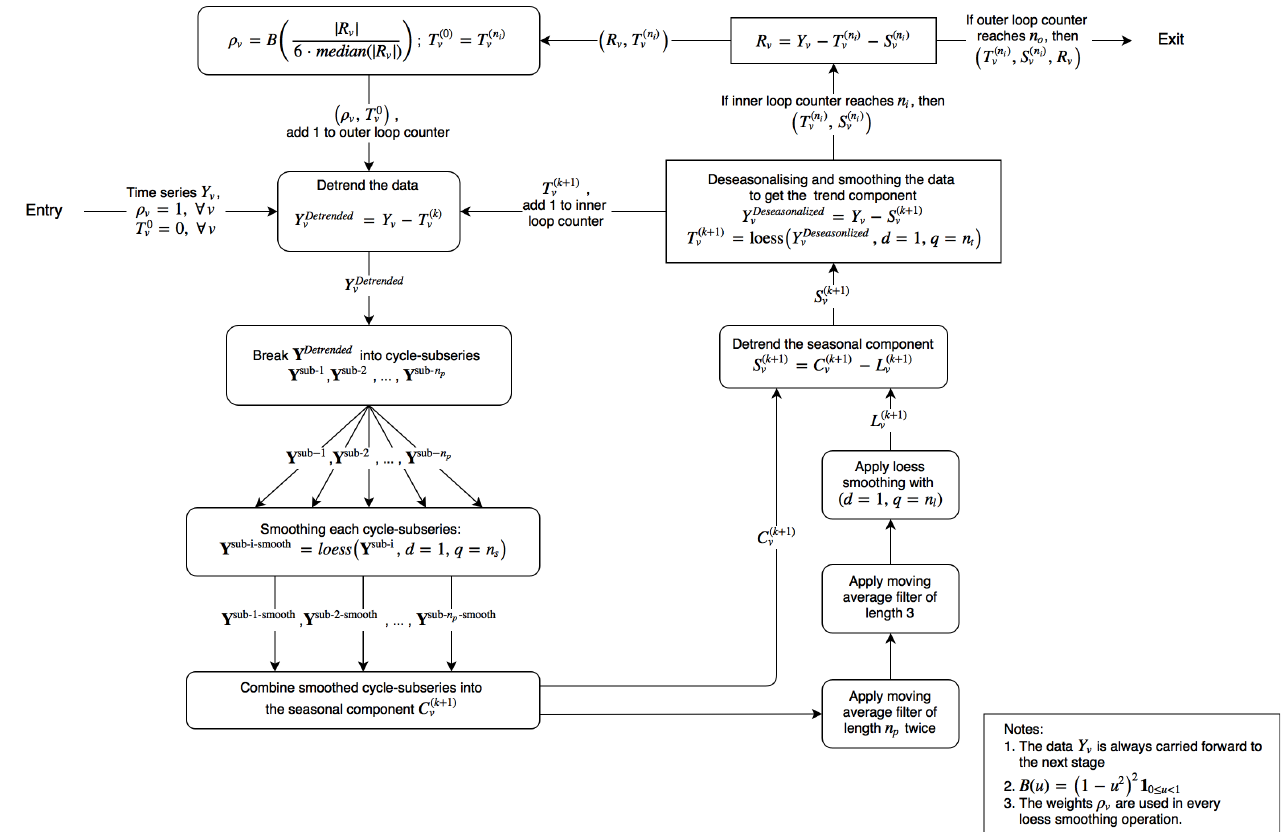
Figure 1. Schematic representation of STL, where k is a running integer index in the inner loop starting from 0 to n i